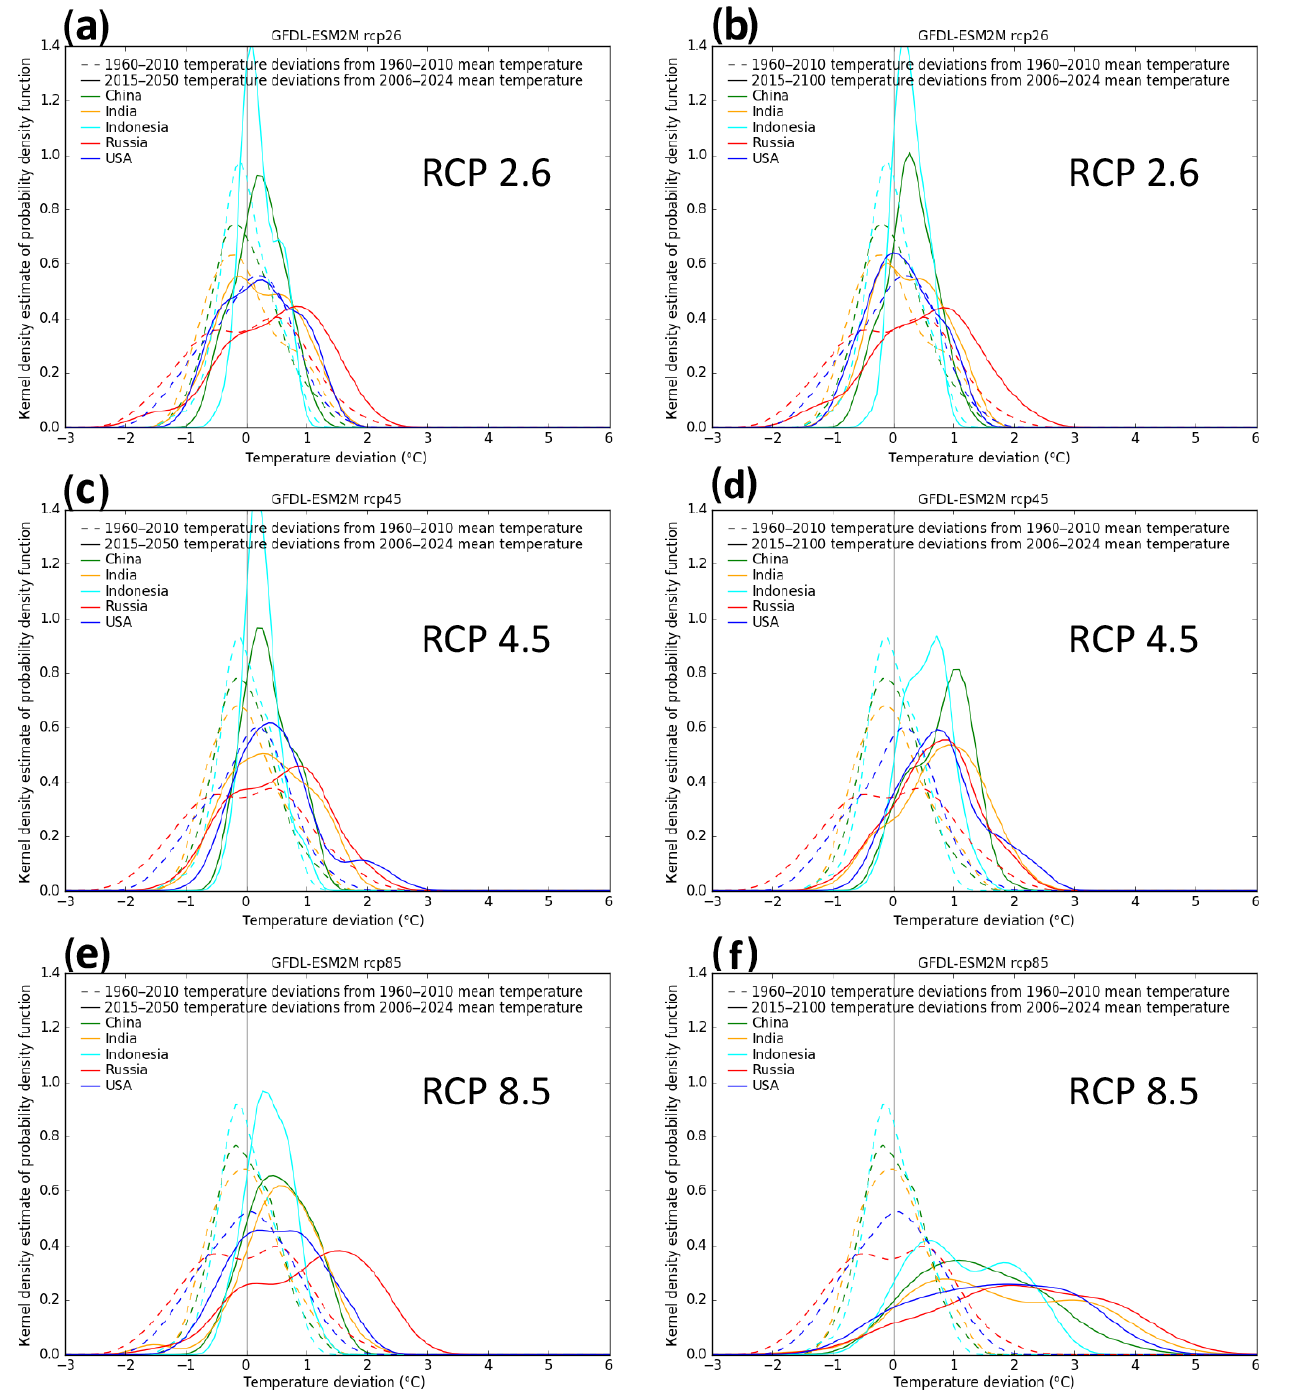
Figure A2. Comparing temperature deviations in the past and future. From the GFDL-ESM2M GCM, a comparison of annual temperature deviations for the historical (dashed) and future periods (solid) of 2015–2050 (a, c, e) and 2015–2100 (b, d, f) for China, India, Indonesia, Russia, and the US (colours), and for RCP2.6 (a, b) , RCP4.5 (c, d) , and RCP8.5 (e, f) .